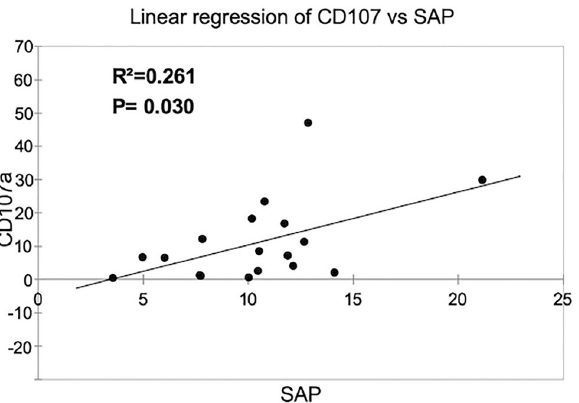
Fig 5. A positive correlation between SAP expression and a reduced NK cell cytotoxicity is revealed in B-ALL patients with WBC over 50,000xmm 3 . A positive correlation study was applied to 18 pre-B-ALL patients, where was possible to determine both NK cell-mediated cytotoxicity and SAP analysis expression. The R 2 - and P values are